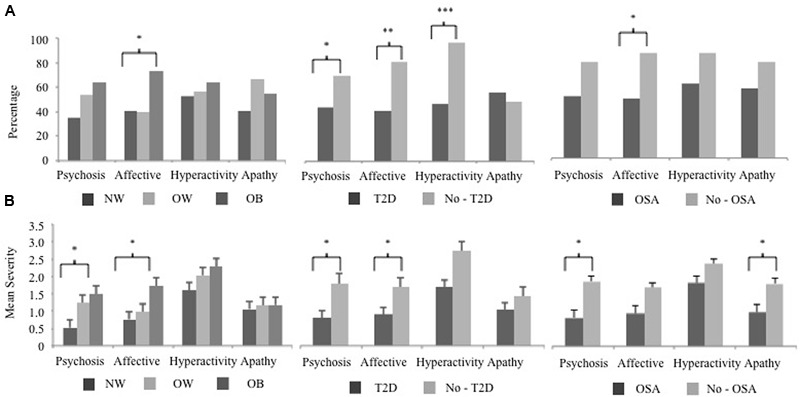
The NPI-Q cluster frequency and severity of BMI, T2D, and OSA MCI subject groups. The 12 NPI-Q symptoms domains are clustered into four groups of, Hyperactivity (agitation, disinhibition, irritability, motor disturbances, and euphoria), Apathy (apathy, appetite), Affective (depression, anxiety) and Psychosis (delusions, hallucinations, night-time behaviors). (A) The frequency of each NPI-Q cluster is plotted for BMI, T2D, and OSA groups. Cluster frequency statistics were conducted using the chi-square test of independence (2 degrees of freedom for BMI and 1 degree of freedom for T2D and OSA). (B) The mean (SE) severity of NPI-Q clusters for BMI, T2D, and OSA groups. Mean differences in cluster severity were compared using the analysis of variance (ANOVA) model for BMI and a Student’s t-test for T2D and OSA. Significant associations are marked as follow, ∗p < 0.05, ∗∗p < 0.01, ∗∗∗p < 0.001. NPI-Q, Neuropsychiatric Inventory Questionnaire; MCI, mild cognitive impairment; BMI, body mass index; T2D, type 2 diabetes; OSA, obstructive sleep apnea.